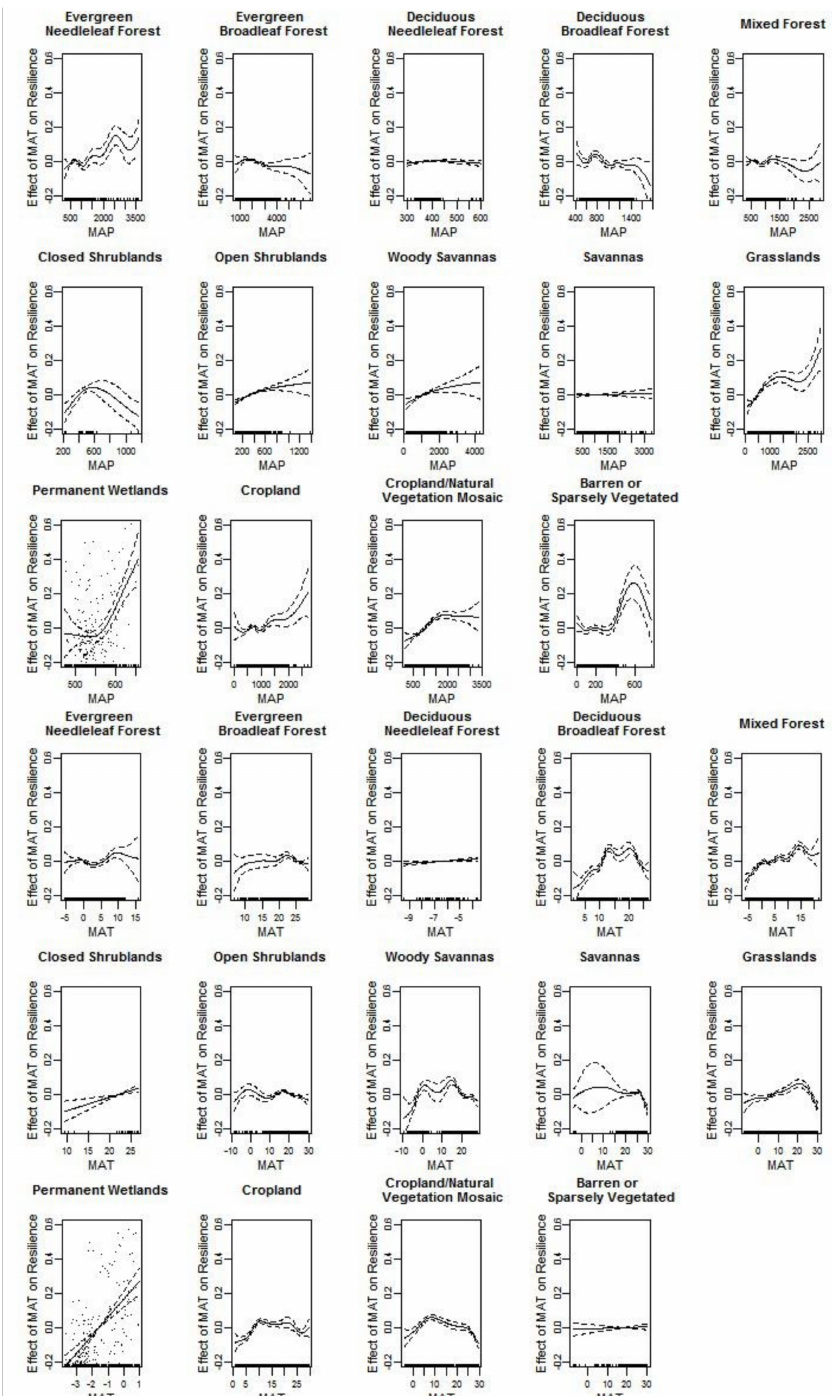
Figure 12. Resilience as a function of MAP and MAT on a global scale in di ff erent land-cover types. The black solid lines represent the mean curve from an ensemble of six curves. The dashed lines highlight the range of the individual ensemble members. The distributions of the available MAP and MAT observations are indicated by the density of the vertical lines above the